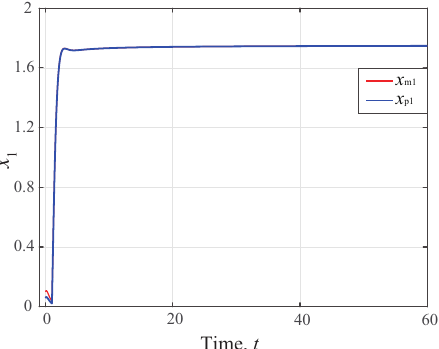
( t ) and x m ( t ) . 1 1